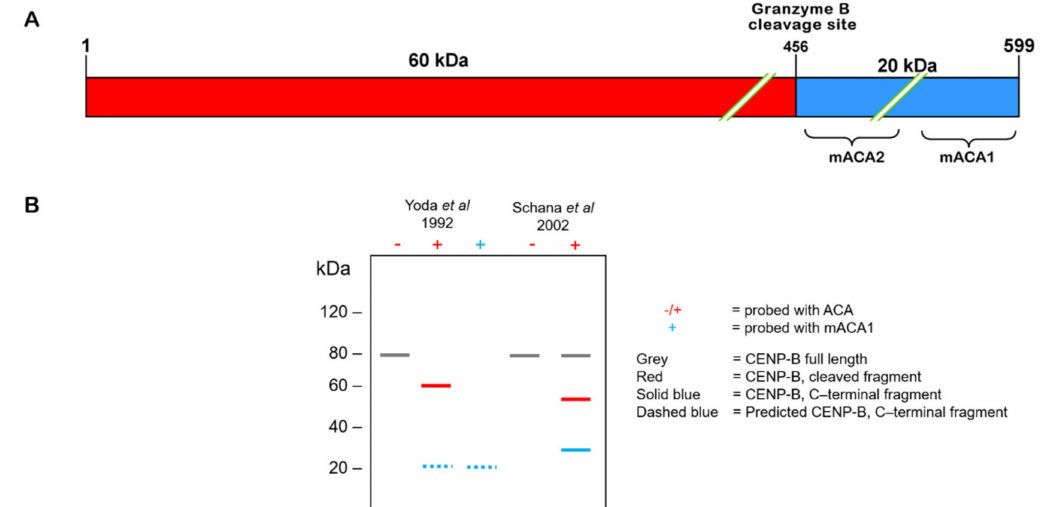
Figure 2. Specificity of CENP-B cleavage correlates with ACA epitope preservation. ( A ) Full-length CENP-B is 80 kDa, with the mACA1 and mACA2 epitopes residing in the terminal 20 kDa. The glutamate-rich, acidic domains are predisposed to cleavage by Glu-C (green slashes), while granzyme B has a single sequence-specific site. In vitro CENP-B cleavage by Glu-C would be expected to produce a 60 kDa fragment when probed by ACAs but would likely ablate the major ACA epitopes within the terminal 20 kDa. By contrast, in vitro CENP-B cleavage by granzyme B would be expected to produce two fragments approximately 60 and 20 kDa in size and both detected by ACAs. ( B ) Western blot schematic of in vitro CENP-B cleavage studies. CENP-B purified from Hela cell nuclear extracts, − /+ Glu-C digestion, probed with ACAs or monoclonal CENP-B antibody (mACA1) (Yoda et al. 1992). Note the lack of 60 kDa band detection when probed with mACA1, consistent with Glu-C cleavage at both acidic regions [50]. Synthetic CENP-B from in vitro transcription/translation, − /+ granzyme B digestion, probed with ACA serum (Schana et al. 2002). The presence of uncleaved CENP-B is likely a reflection of protein-to-enzyme ratios within the reaction